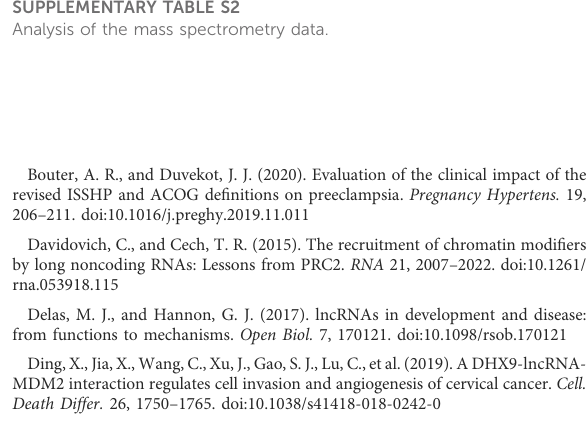
SUPPLEMENTARY TABLE S1 The list of PCR/ChIP-PCR primers and siRNAs sequences. SUPPLEMENTARY TABLE S2 Analysis of the mass spectrometry